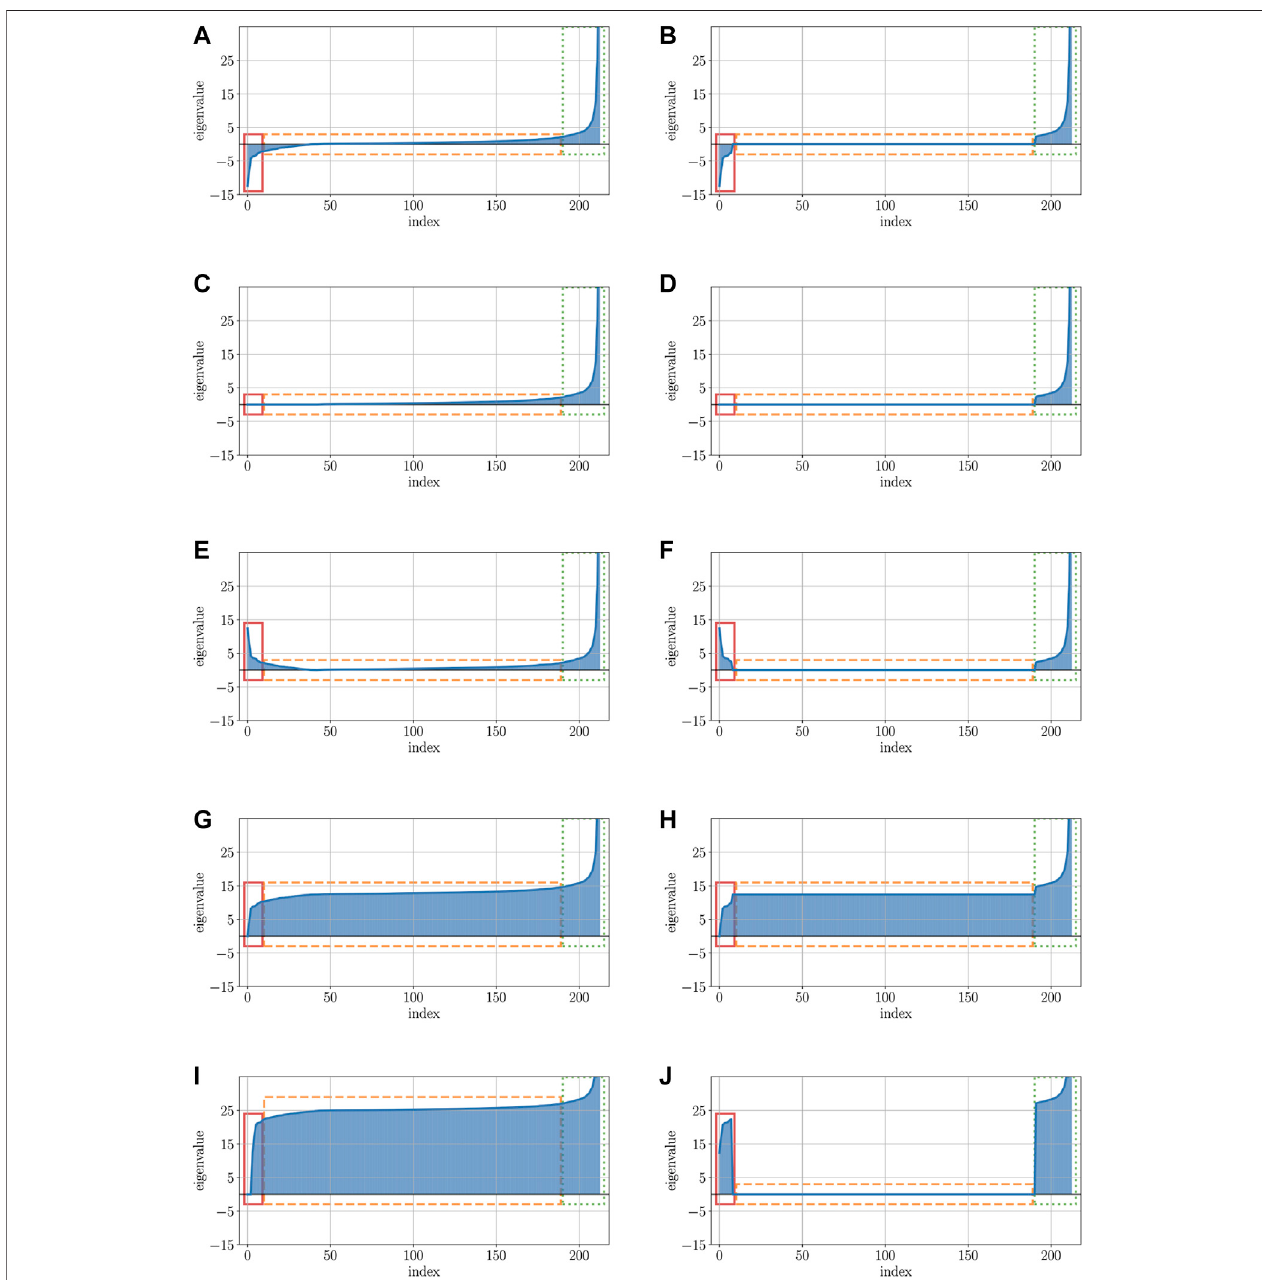
FIGURE5| Visualizationsoftheproteindata ’ seigenspectraafterapplyingvariouscorrectionmethods. (A) Visualizationoftheoriginaleigenspectrumwithpos.and neg. eigenvalues of the protein dataset. (B) Low-rank representation of the original eigenspectrum from Figure 5A . (C) Visualization of the original eigenspectrum of Figure 5A after clipping all neg. eigenvalues. (D) Visualization of the low-rank approximated eigenspectrum after clipping all neg. eigenvalues. (E) Visualization of the original eigenspectrum of Figure 5A after fl ipping all neg. eigenvalues. (F) Visualization of the low-rank approximated eigenspectrum after fl ipping all neg. eigenvalues. (G) Visualizationoftheoriginaleigenspectrumof Figure5A aftershiftingallneg.eigenvalues. (H) Visualizationofthelow-rankapproximatedeigenspectrum after shifting all neg. eigenvalues. (I) Visualization of the original eigenspectrum of Figure 5A after advanced shift. (J) Visualization of the low-rank approximated eigenspectrum of Figure 5B after advanced